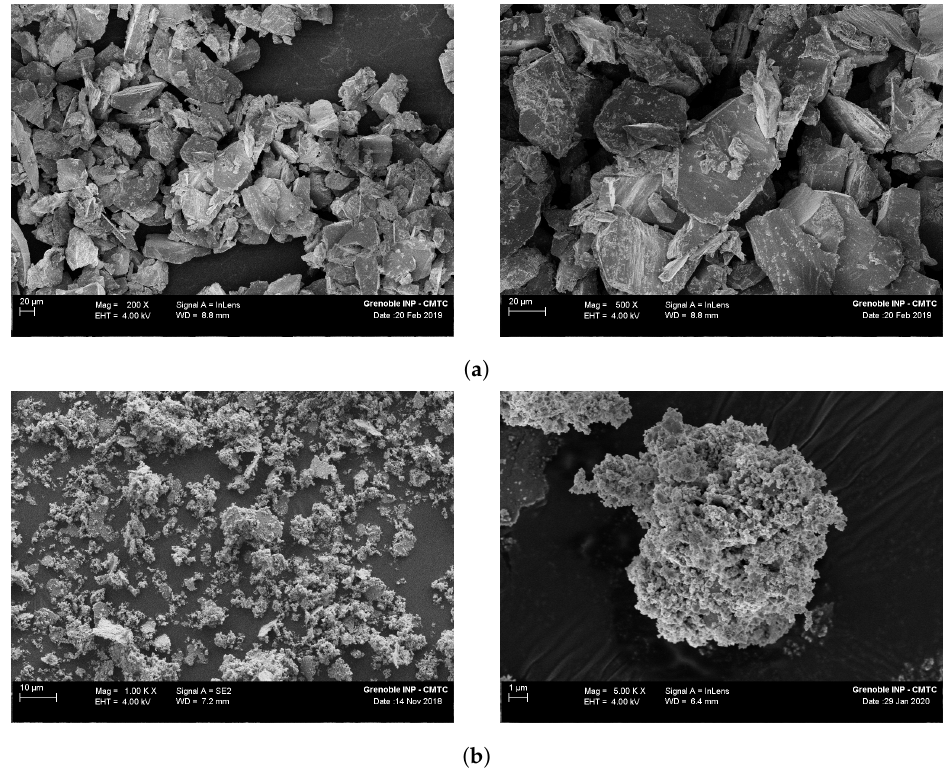
Figure 12. SEM secondary electron mode images of the ( a ) pyrrhotite 25–50 and ( b ) pyrrhotite < 25 samples at two levels of